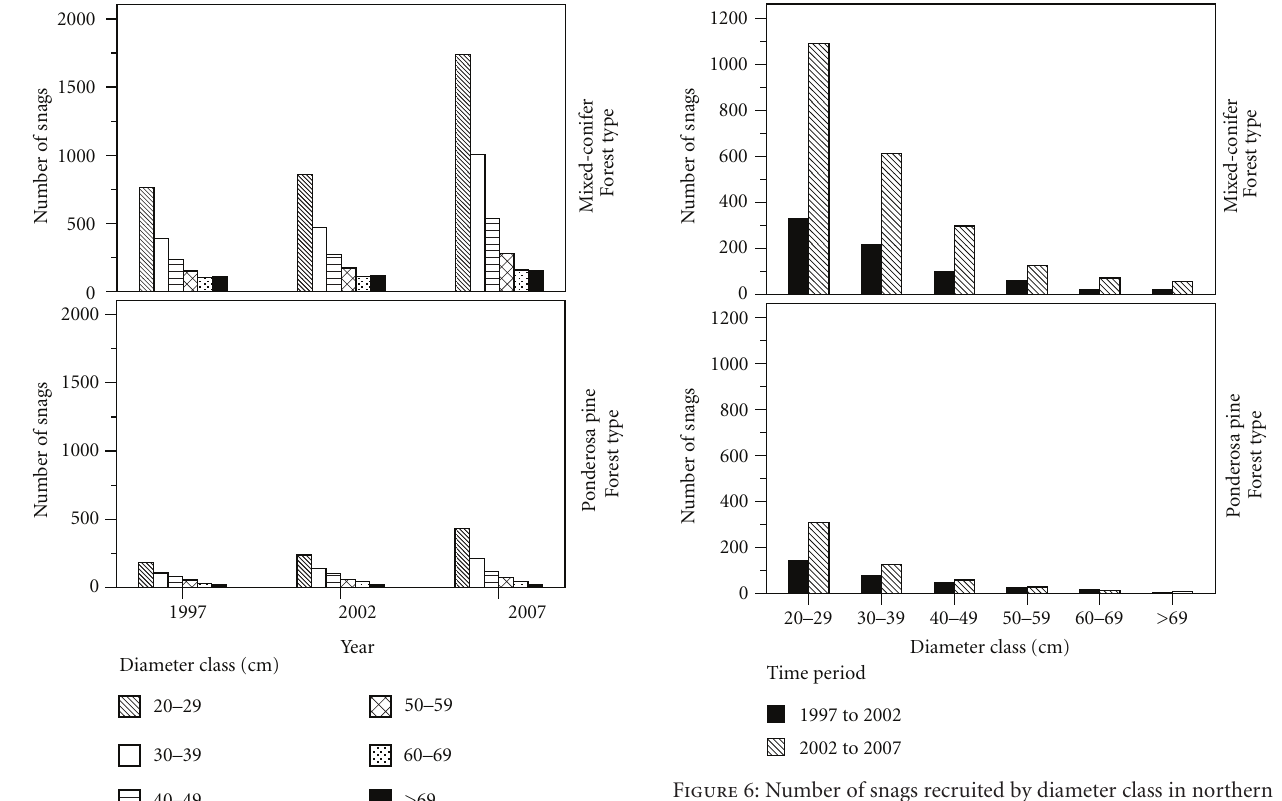
Figure 6: Number of snags recruited by diameter class in northern Arizona mixed-conifer and ponderosa pine forests from 1997 to 2002 and from 2002 to 2007. Recruitment occurred across all size classes and was greater in most size classes from 2002 to 2007 than from 1997 to 2002. Recruitment during the latter period especially was concentrated in the smaller size